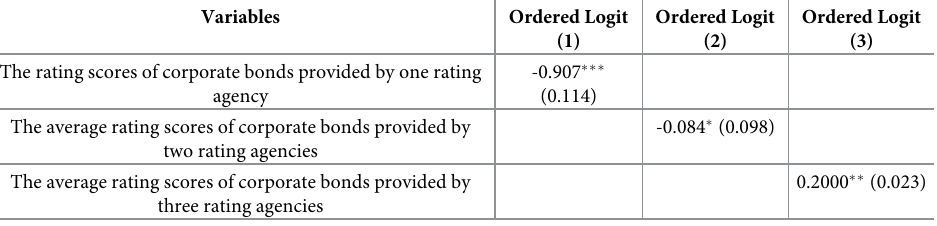
Table 9. Robust results of rating upgrades.